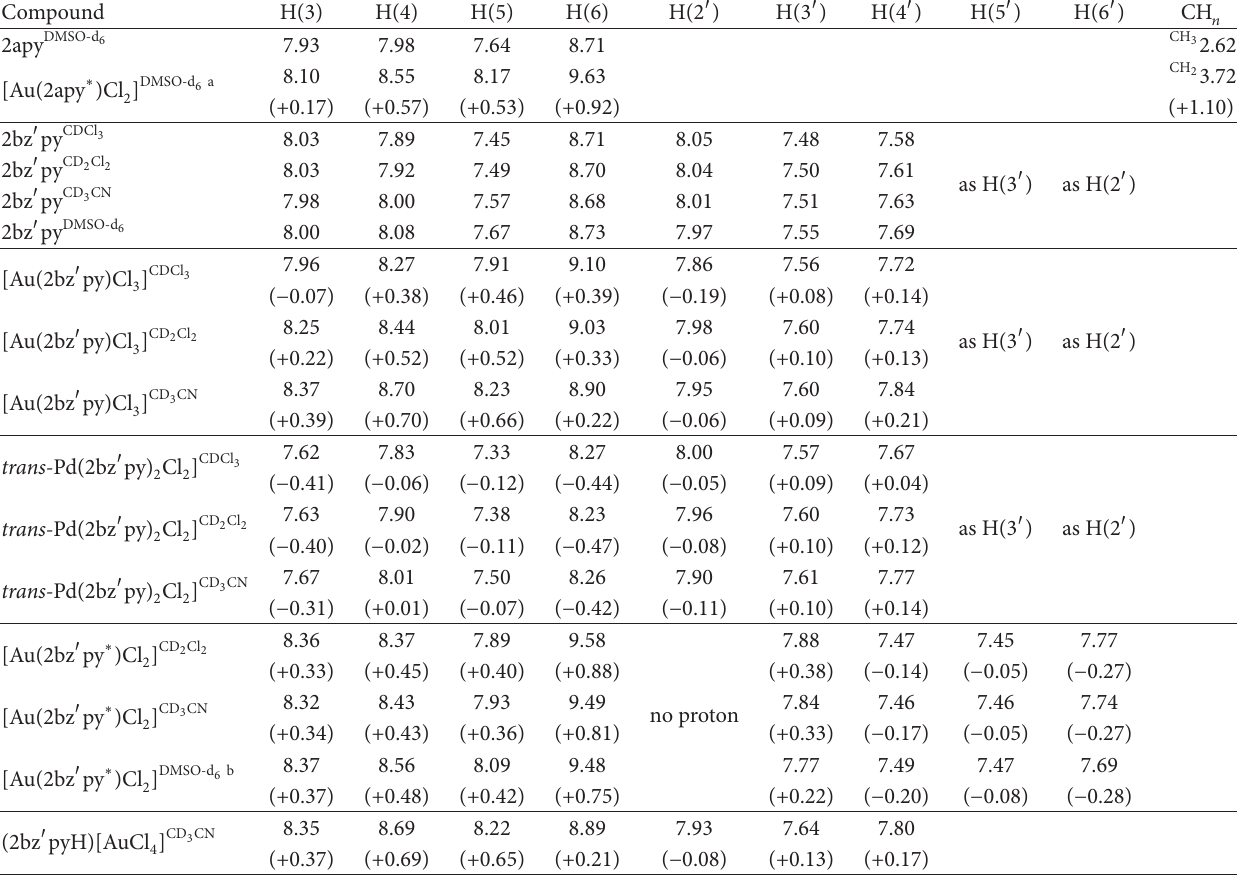
T 1: 1 H chemical and coordination/protonation shis (in parentheses) for Au(III) and Pd(II) chloride complexes, organometallics, and salts with 2apy or 2bz